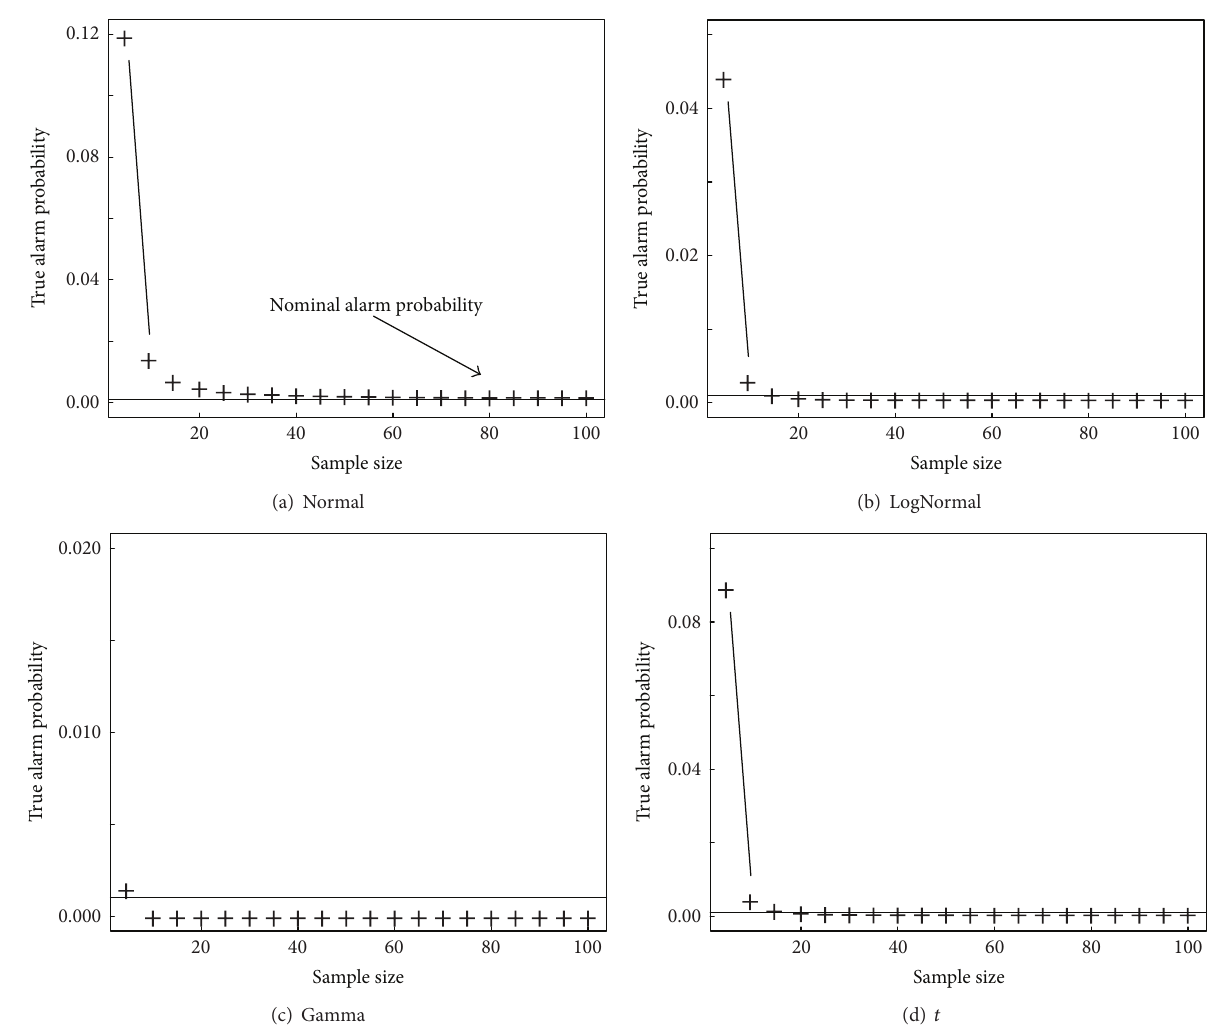
Figure 3: True alarm probability versus sample size (nominal alarm probability is 0.001) for (a) normal, (b) lognormal, (c) gamma (1, 0.1), and (d) 𝑡(2) . The true alarm probabilities were estimated by simulation of 10 4 observations in R , and results are repeatable to within ± 0.0001.